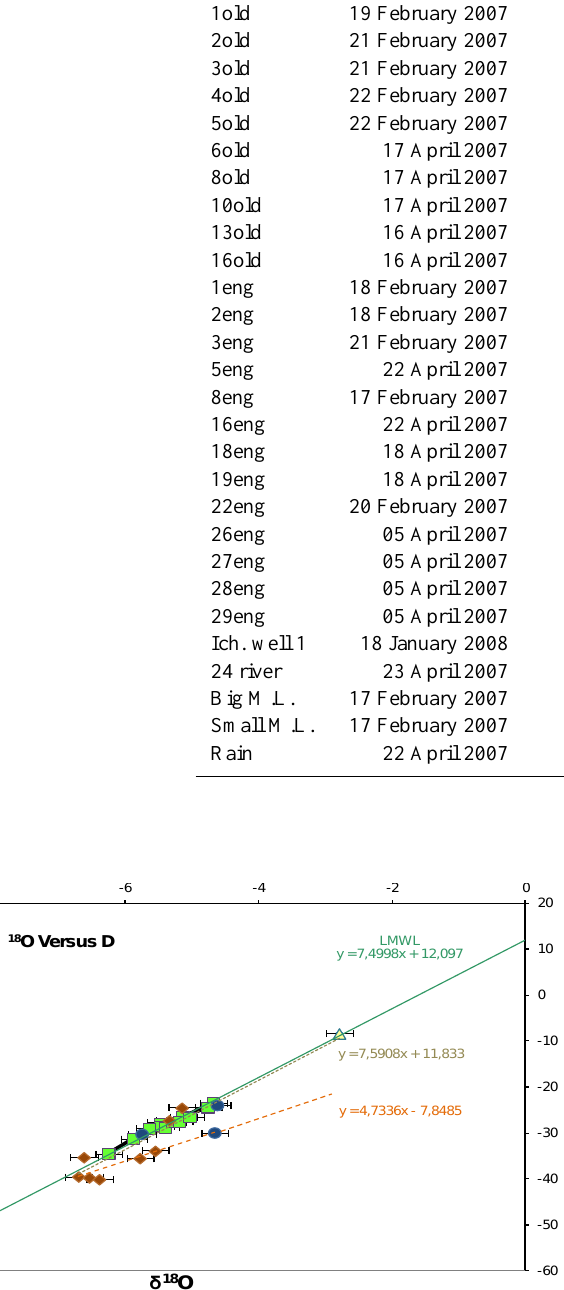
Fig. 8. Plot of 2 H vs. 18 O content with groundwater and evaporation regression